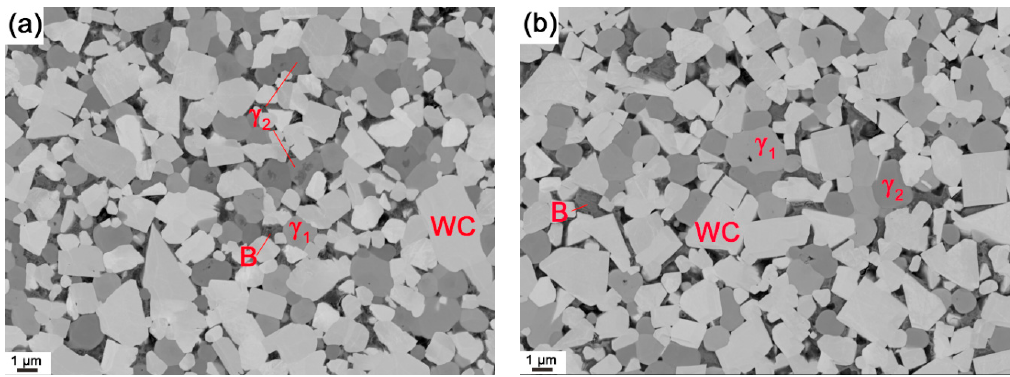
Figure 3. SEM backscattered electron micrographs of ( a ) composite 1 and ( b ) composite 2 after sintering at 1410 °C for 1 h. The equilibrium phases present in the final microstructure are indicated; the letter B refers to the binder phase.